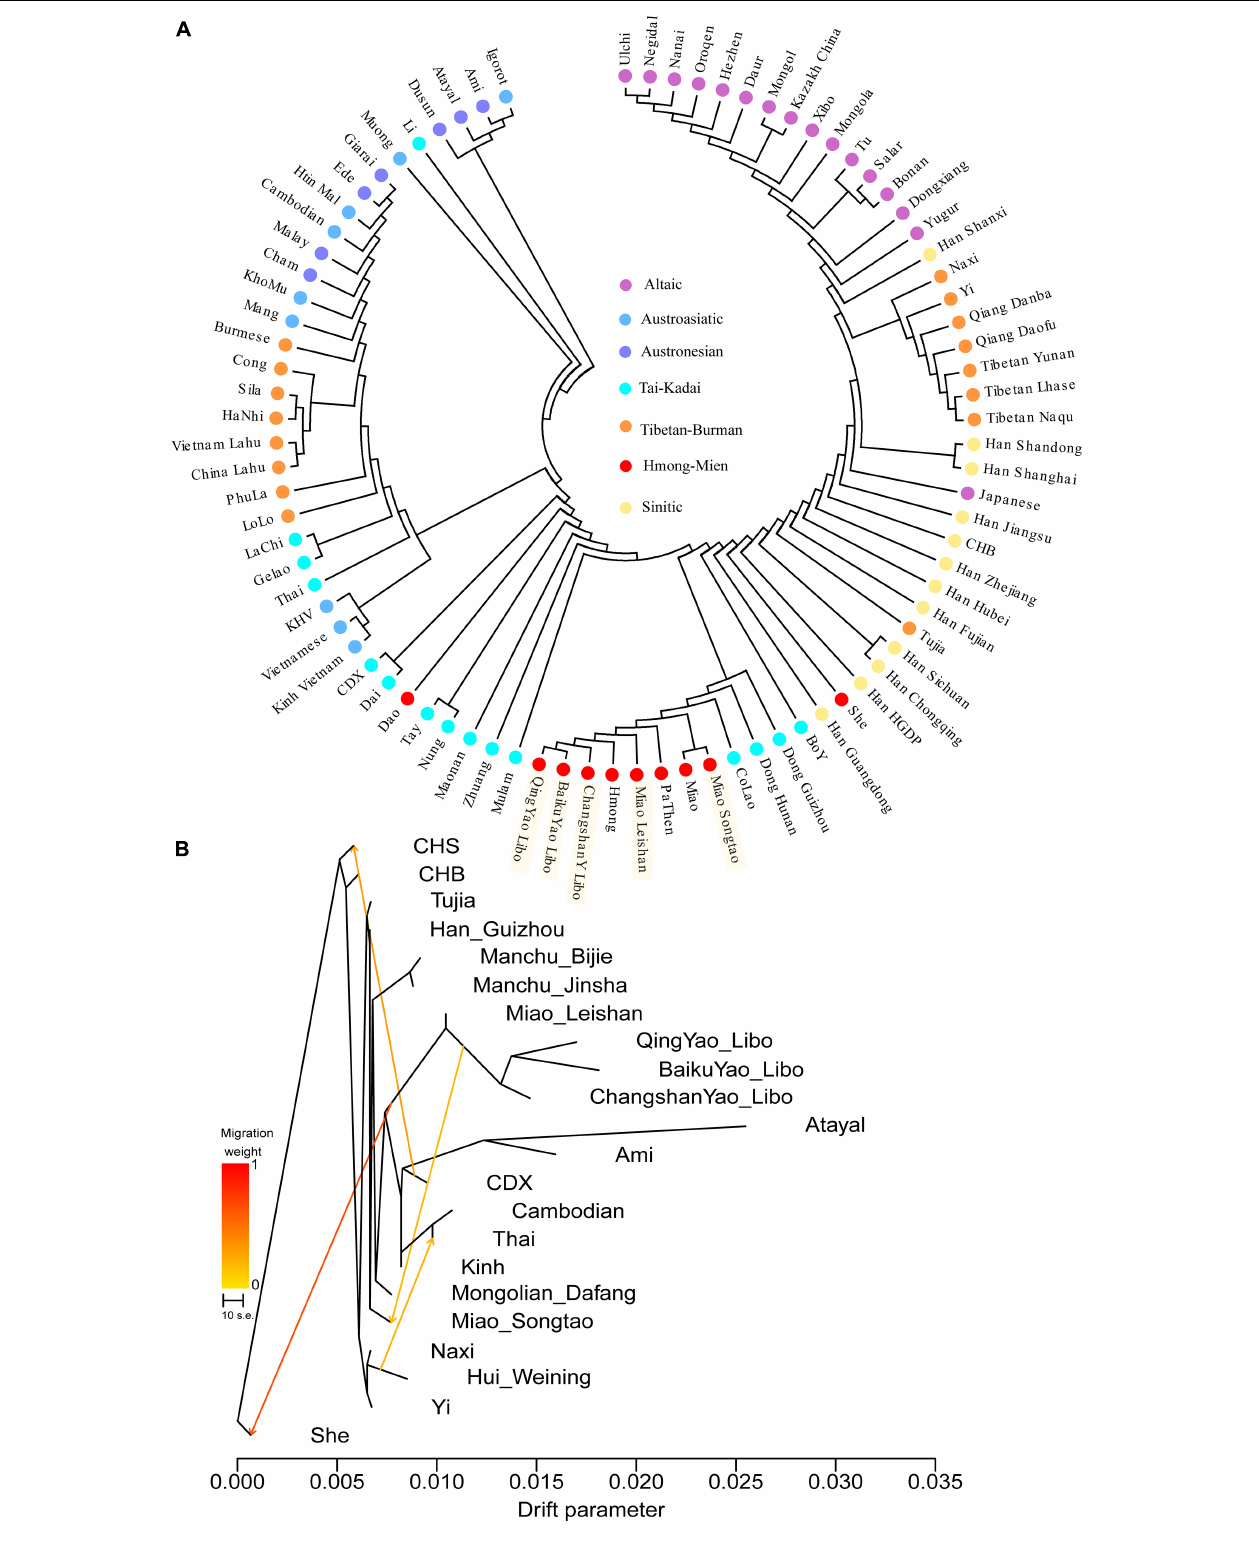
FIGURE 2 | Phylogenetic relationships between our studied Hmong-Mien-speaking populations and other reference populations. Mega-based phylogenetic relationships without migration events (A) and TreeMix-based phylogenies with migration events (B) .